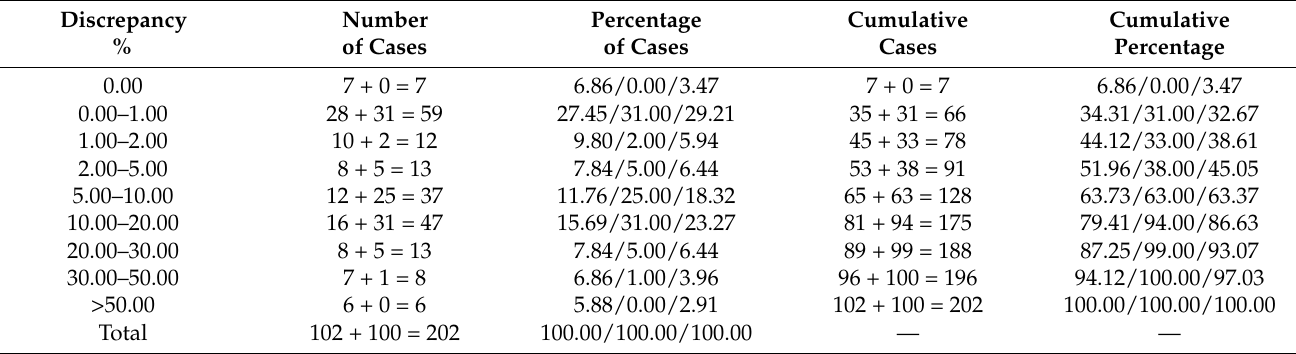
Table 33. Comparative accuracy of extrapolation and CFD–RANS